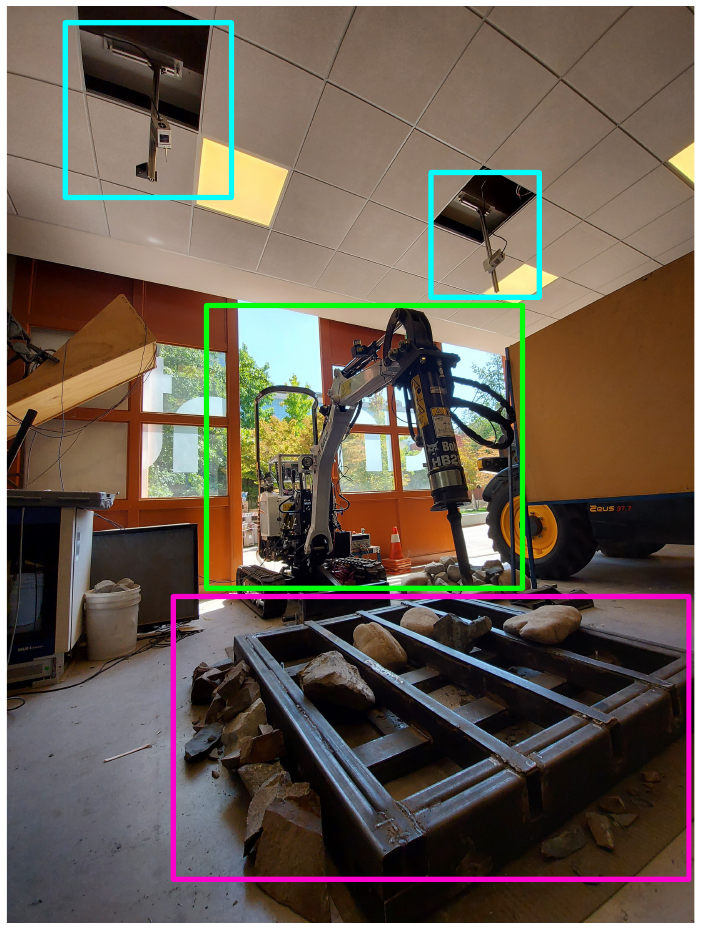
Figure 18. Experimental setup used for real-world testing. The Bobcat E10 hydraulic mini-excavator is marked with a green frame, the grizzly is marked with a magenta frame, and the sensors (LIDARs and cameras) are marked with cyan frames.